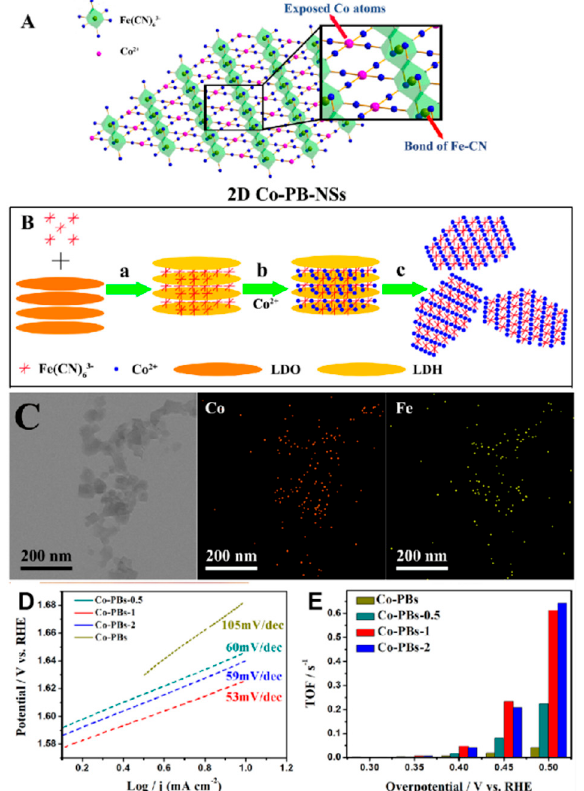
Figure 7. ( A , B ) The schematic diagrams of the 2D layered CoFe-PBA nanosheet and its synthesis process; ( C ) STEM-EDS elemental mapping images of Co and Fe elements, respectively, show their distributions in the fabricated nanosheets; ( D ) Tafel plots of the CoFe-PBA nanosheets formed with different loading of the conductive substrates; and ( E ) TOF/oxidative cobalt site (Co II ). Adapted with the permission from [82]. Copyright © 2020 Elsevier.